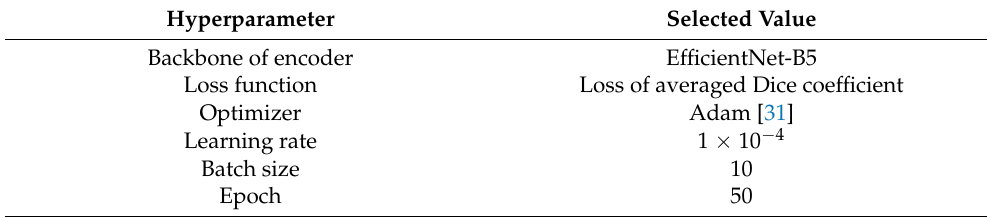
Table 2. Hyperparameters for training.